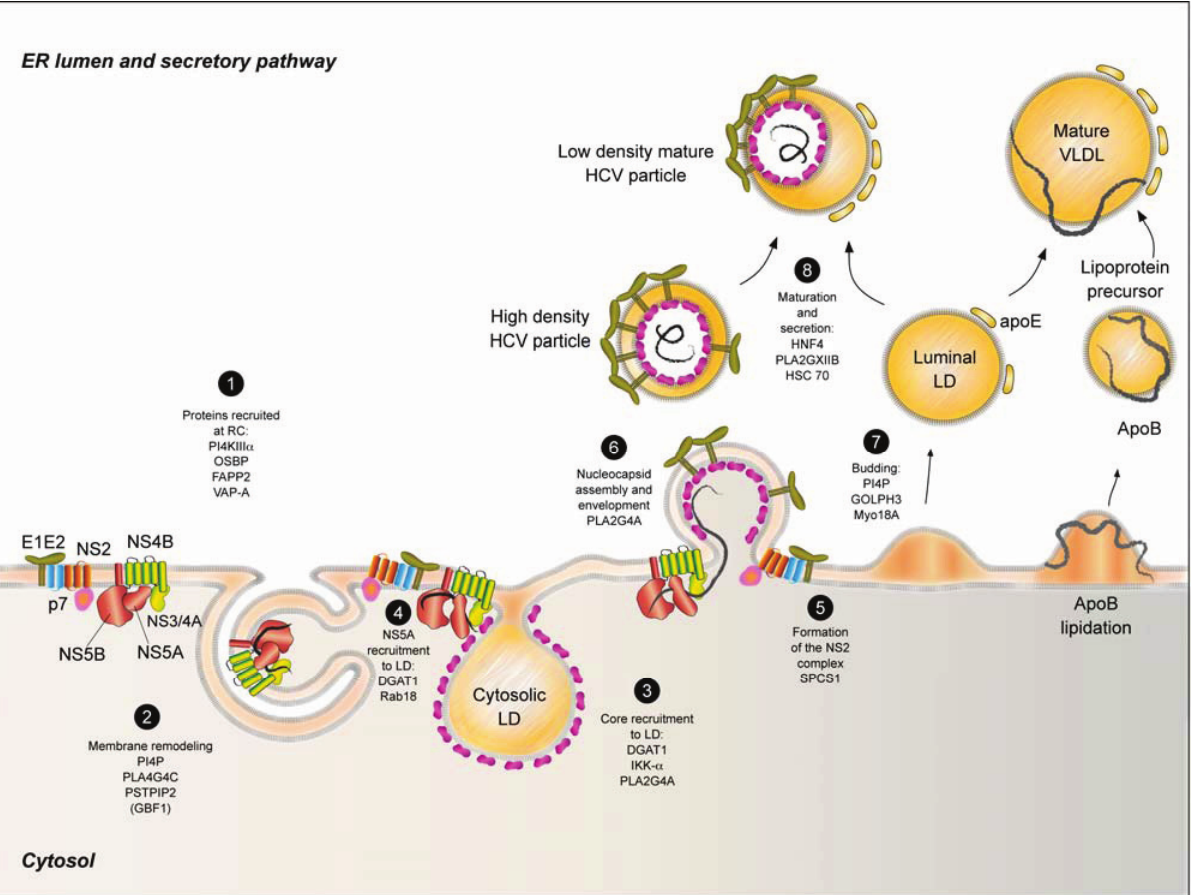
Figure 3. Model of viral replication and assembly of the infectious viral particle. Following viral protein processing, the mature proteins assemble in complexes. The NS2 complex consists of the envelope proteins E1 and E2, p7 viroporin and NS2 protease. The replication complex gather NS3 protease and its co-factor NS4A, NS4B, NS5A and NS5B, which are associated with modified membranes forming the “membranous web”. The cellular proteins PI4KIIIalpha, OSBP, FAPP2 and VAP-A are also recruited to the replication complexes, regulating membrane lipid exchange ( 1 ). NS4B protein induces the reorganization of intracellular membranes in special partially closed double membrane structures where replication occurs. The host proteins PLA2G4C and PSTPIP2 influence this membrane remodeling. Furthermore, GBF1 is involved in an early step of viral replication and it indirectly affects membrane remodeling ( 2 ). In the early stage of assembly core associates with LD following the recruitment of the replication complex through core-NS5A interaction. Several endogenous factors are involved in core and NS5A recruitment to LD and DGAT1 plays a central role in this relocalization ( 3 and 4 ). NS2 complexes ( 5 ) may interact with replication complexes accumulating in dotted structures in the proximity of LD. The presence of the three viral modules triggers the synchronous nucleocapsid assembly and envelopment potentiated by endogenous factors like PLA2G4A ( 6 ). Following the host-mediated budding ( 7 ), the immature viral particle fuses or attaches to a luminal lipid droplet through apoE-E1E2 interaction. The LVP takes a similar secretion and maturation route as VLDL, influenced by the cellular proteins HNF4, PLA2GXIIB and HSC70 ( 8